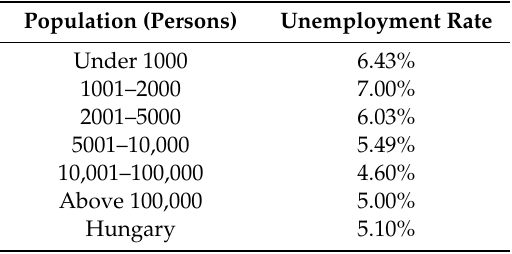
Table 2. Unemployment rate by population categories.